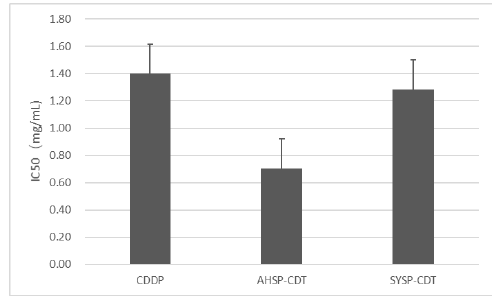
Figure 10. The IC50 values of the three compound Danshen preparations on A549 cells at the given time points marked with dashed lines in Figures 7–9. Data are expressed as x ± s ( n = 3).